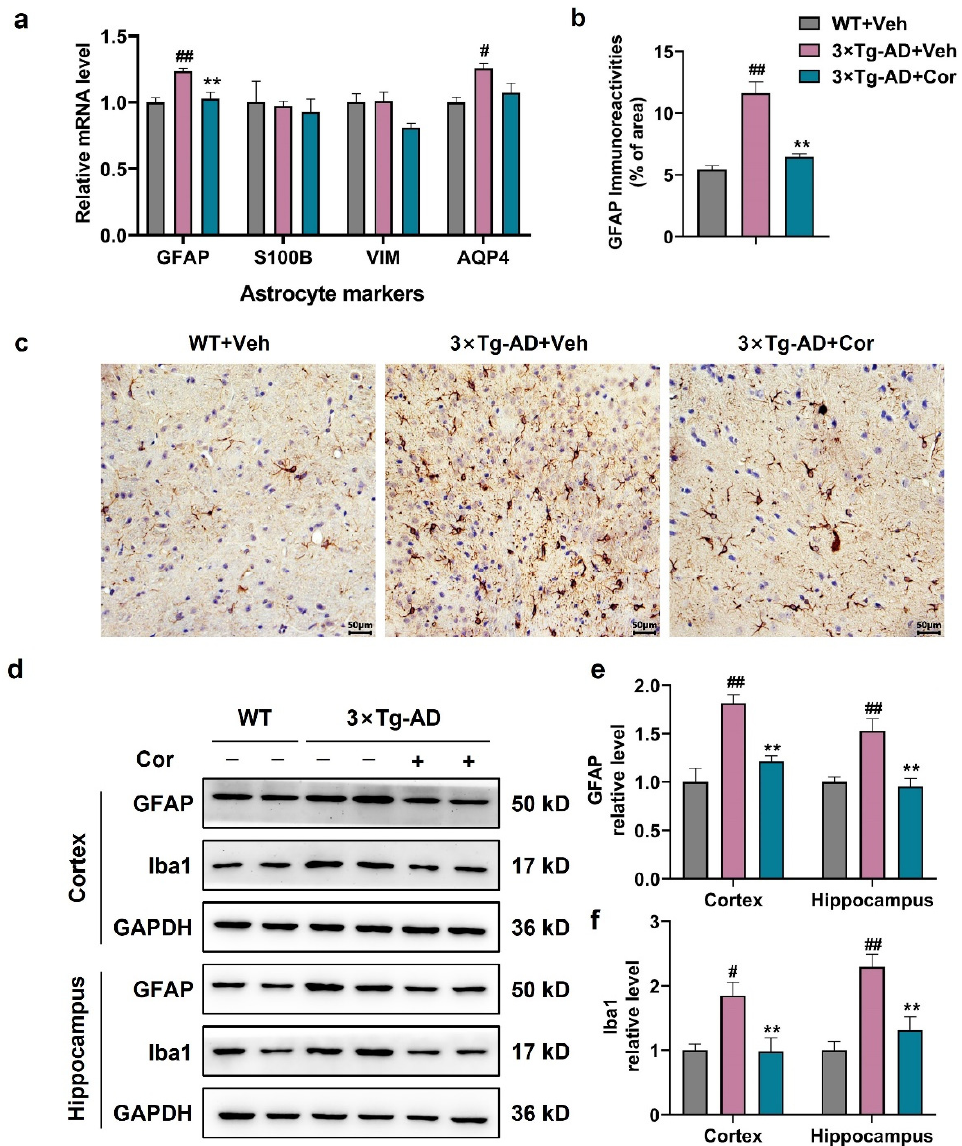
Figure 3. Cornuside inhibited glial activation in 3 × Tg-AD mice. ( a ) Quantitative PCR of astrocyte markers GFAP, S100B, Vim, and AQP4 from the cortex of 3 × Tg-AD mice in the presence or absence of cornuside compared to WT control mice. The reference gene used was GAPDH, n = 5 per group. ( b ) Quantification and ( c ) immunohistochemical images of GFAP-positive area in the cortices of experimental mouse brains. ( d ) The typical WB images and ( e , f ) quantitative assessments of GFAP and Iba1 protein in the cortex and hippocampus of 3 × Tg-AD mice in the presence or absence of cornuside compared with WT control mice ( n = 6 per group), respectively. Data are shown as mean ± SEM. # p < 0.05 and ## p < 0.01 relative to WT + Veh; ** p < 0.01 relative to 3 × Tg-AD + Veh group.